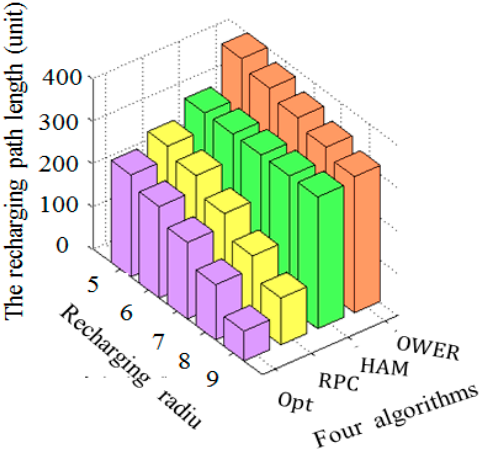
Figure 16. The comparison of path length of the four algorithms by varying the recharging radius ranging from 5 to 9 distance units.